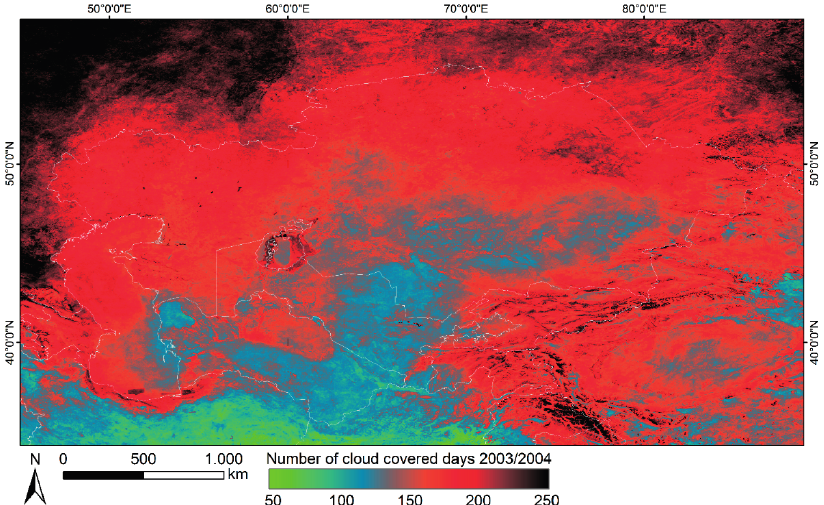
Figure 4. Number of cloud covered days during the hydrological year 2003/2004 as derived from MODIS daily snow cover products